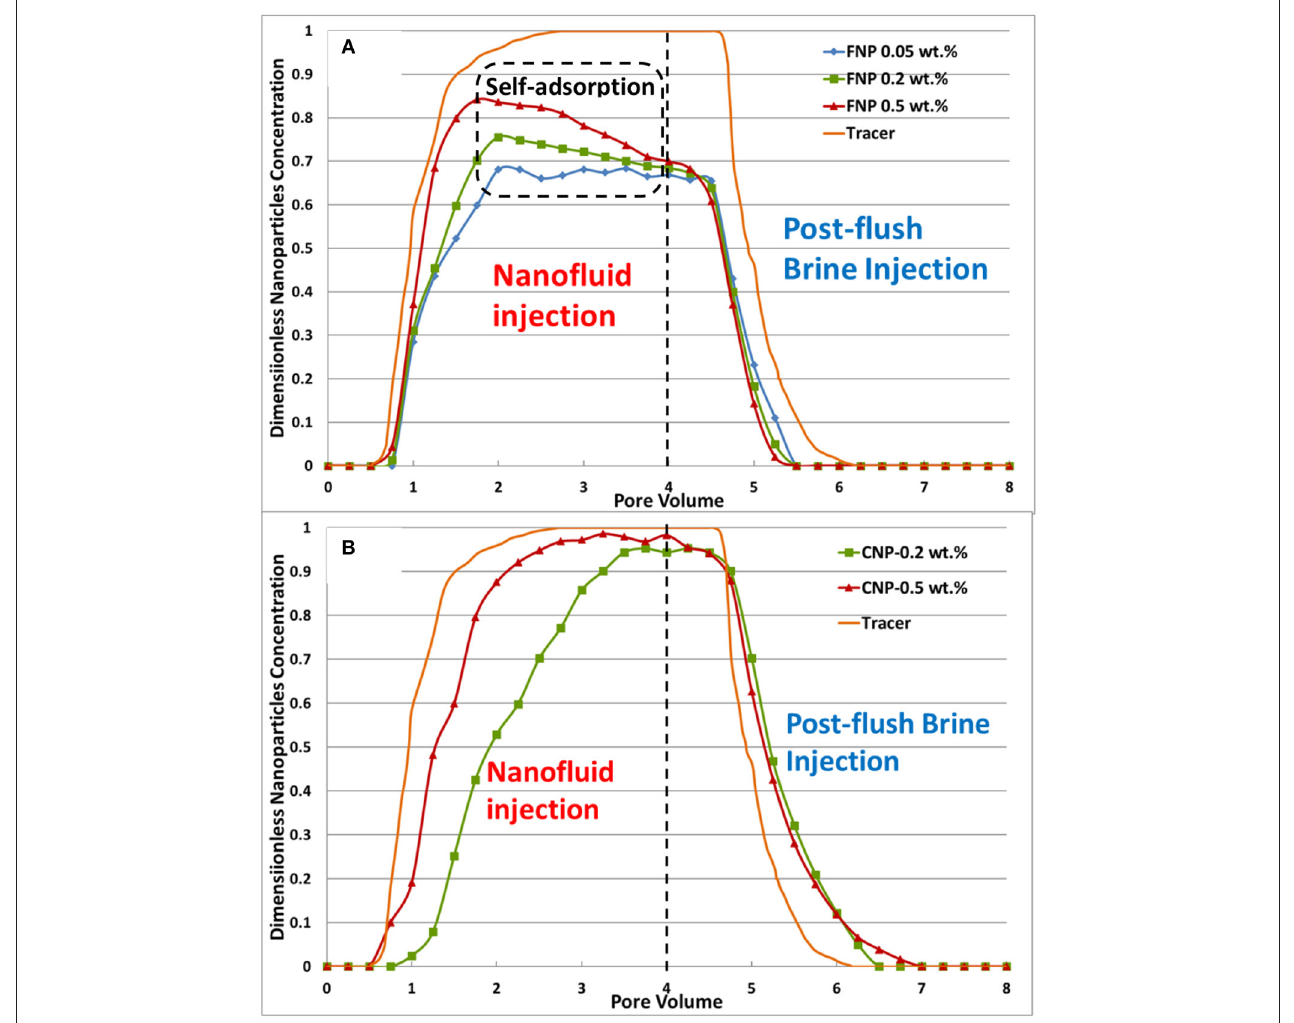
FIGURE 12 | Nanoparticles adsorption curves: (A) core plugs treated with FNP; (B) core plugs treated with